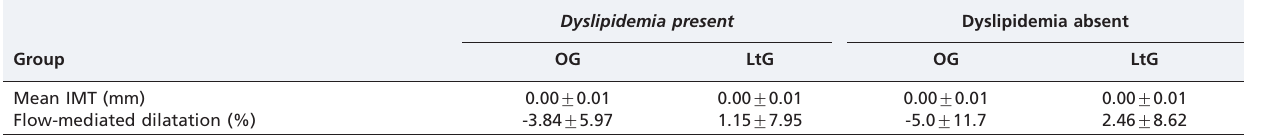
Table 3 - Changes in brachial FMD and mean EIM after one year of follow-up in the L-T4 group and the observation group based on the presence or absence of dyslipidemia.